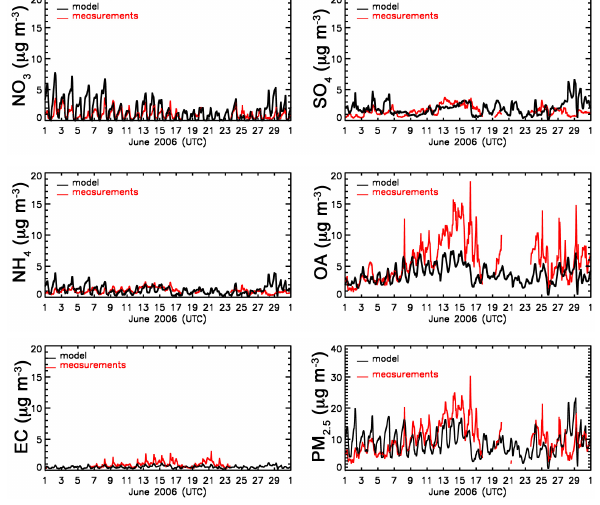
Figure 4. Measured (red) and modelled (black) hourly concentra- tions of particulate nitrate, sulfate, ammonium, organic aerosols (OA), elemental carbon (EC) and PM 2 . 5 (sum of all species shown above) at Payerne in June 2006. EC was measured by an Aethalometer, and the other components by an